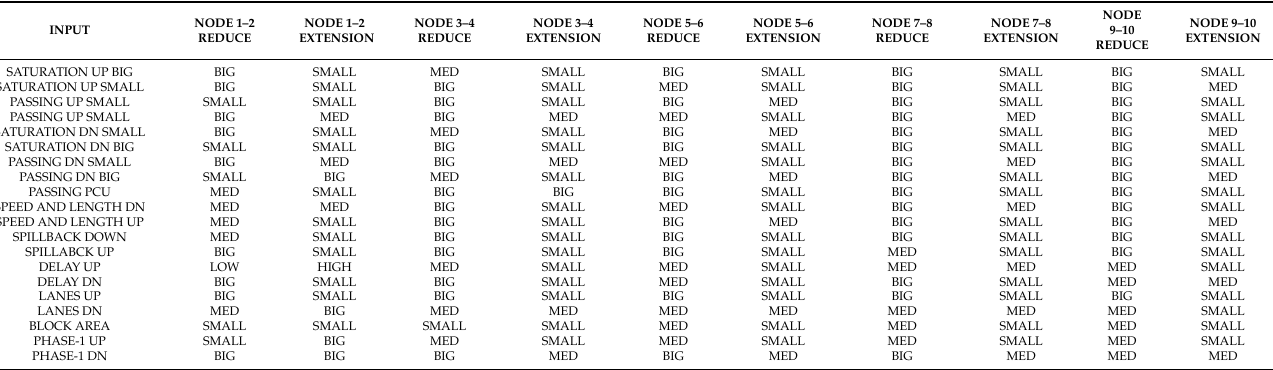
Table 1. Intelligent traffic signal cycle input and output values.